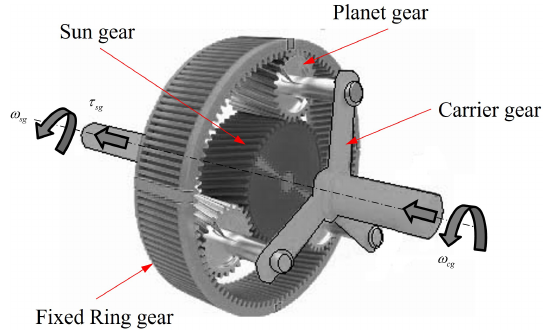
Figure 3. Outline of